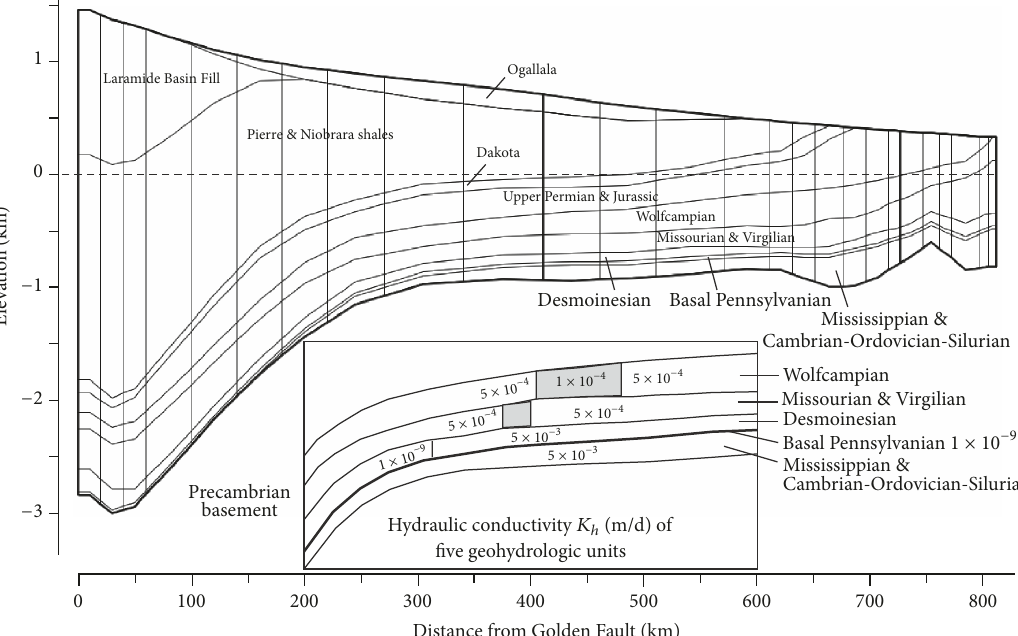
Figure 16: Grid of the fifth model of the sequence, having the geometry at 4.5 Ma, of maximum deposition, used to model the period from 7 to 4.5 Ma. The vertically expanded part of section from 200 to 600 km in the inset shows details of horizontal hydraulic conductivity structure.